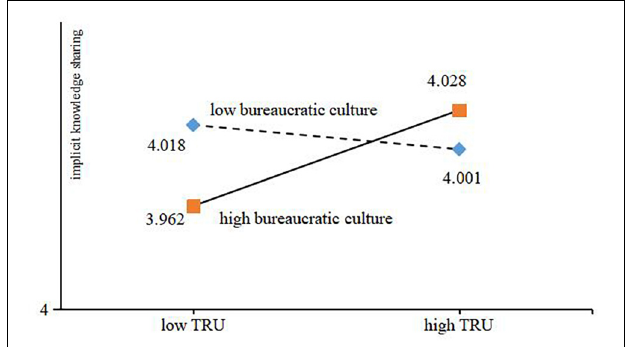
FIGURE 4 | Moderating effect of bureaucratic